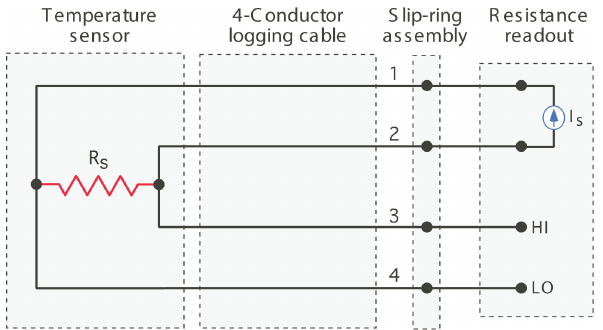
Figure 4. Kelvin (4-wire) resistance circuit used by the USGS portable logging system. The test current I s passes through lines 1 and 2, while the voltage drop across the probe resistance R s is measured using the sense lines (3, 4). Logging cables used with the portable system are 450–900m long. The resistance readout is lo- cated on the surface.